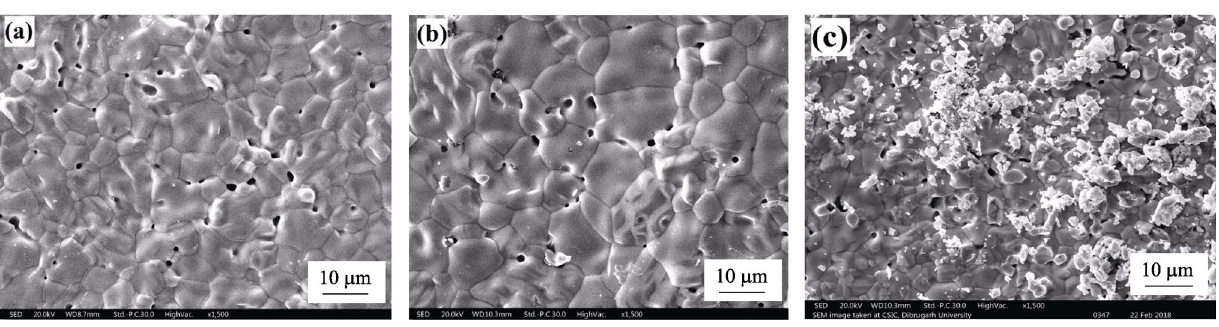
Fig. 2 SEM Micrographs of (a) x = 0.10, (b) x = 0.175, and (c) x = 0.25 of Bi 2 V 1– x Al x /2 Ti x /2 O 5.5– δ .